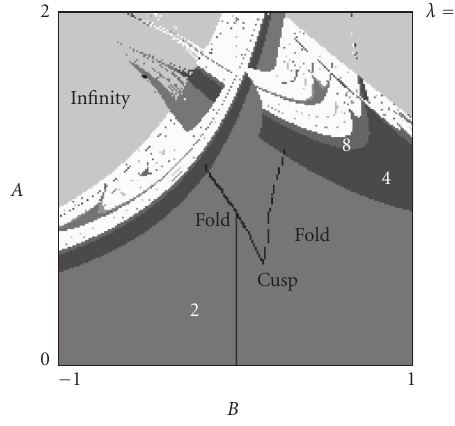
Figure 2.1. Parameter space ( A , B ) of the slave system for fixed parameter of master system λ = 1. Di ff erent tints mean domains of periodical behaviours, chaos is designated by white area. Numbers mean the period of oscillations. Firm and dotted lines are lines of folds (tangent bifurcations), which are crossed at cusp